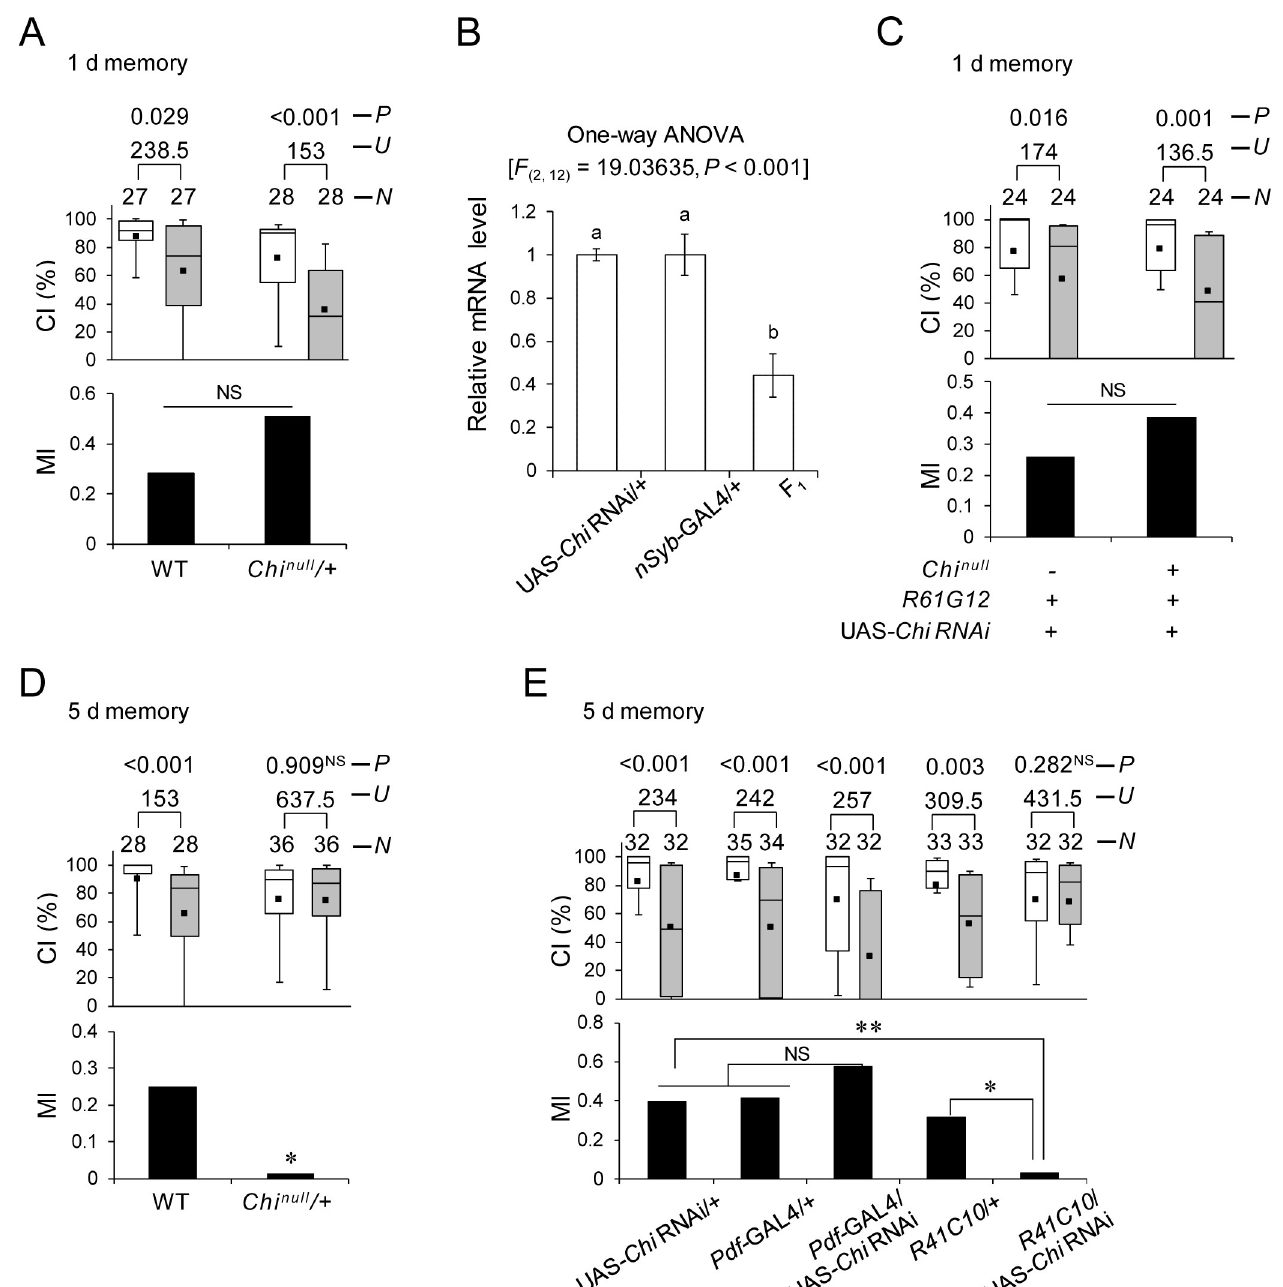
Fig 6. Chi in MB α / β is necessary for LTM. The underlying data can be found in S1 Data. (A) One-day memory after 7-hour conditioning. WT and Chi null / + flies were used. NS, not significant. (B) Real-time qRT-PCR analysis of ap mRNA expression level. nSyb -GAL4 was used for the induction of Chi RNAi (VDRC). Mean ± SEM was calculated from 5 replicates. One-way ANOVA followed by post hoc analysis using Scheffe test for multiple comparisons was used. Bars with the same letter indicate values that are not significantly different ( P > 0.05). (C) Pdf neuron–specific Chi knockdown in Chi null /+ flies. One-day memory after 7-hour conditioning. UAS- Chi RNAi/ +; R61G12/+ (control) and UAS- Chi RNAi/Chi null ; R61G12/+ flies were used. (D) Five-day memory after 7-hour conditioning. WT and Chi null /+ flies were used. � , P < 0.05. (A, C, and D) Box plots for a set of CI data show fifth, 25th, 75th, and 95th centiles. In the box plots, the black square in each box indicates the mean, the line in each box is drawn at the median, the white boxes indicate naive males, and the gray boxes indicate conditioned males. CI, courtship index; MI, memory index; N , sample size; U , Mann–Whitney U ; P , probability. (E) Chi knockdown using Pdf - GAL4 and R41C10 . Five-day memory after 7-hour conditioning. Box plots for a set of CI data show 10th, 25th, 75th, and 90th centiles. In the box plots, the black square in each box indicates the mean, the line in each box is drawn at the median, the white boxes indicate naive males, and the gray boxes indicate conditioned males. CI, courtship index; MI, memory index; N , sample size; U , Mann–Whitney U ; P , probability; � , P < 0.05; �� , P < 0.01; NS, not significant. Chi, Chip; LTM, long-term memory; MB, mushroom body; qRT-PCR, quantitative reverse transcription PCR; RNAi, RNA interference; WT, wild-type.